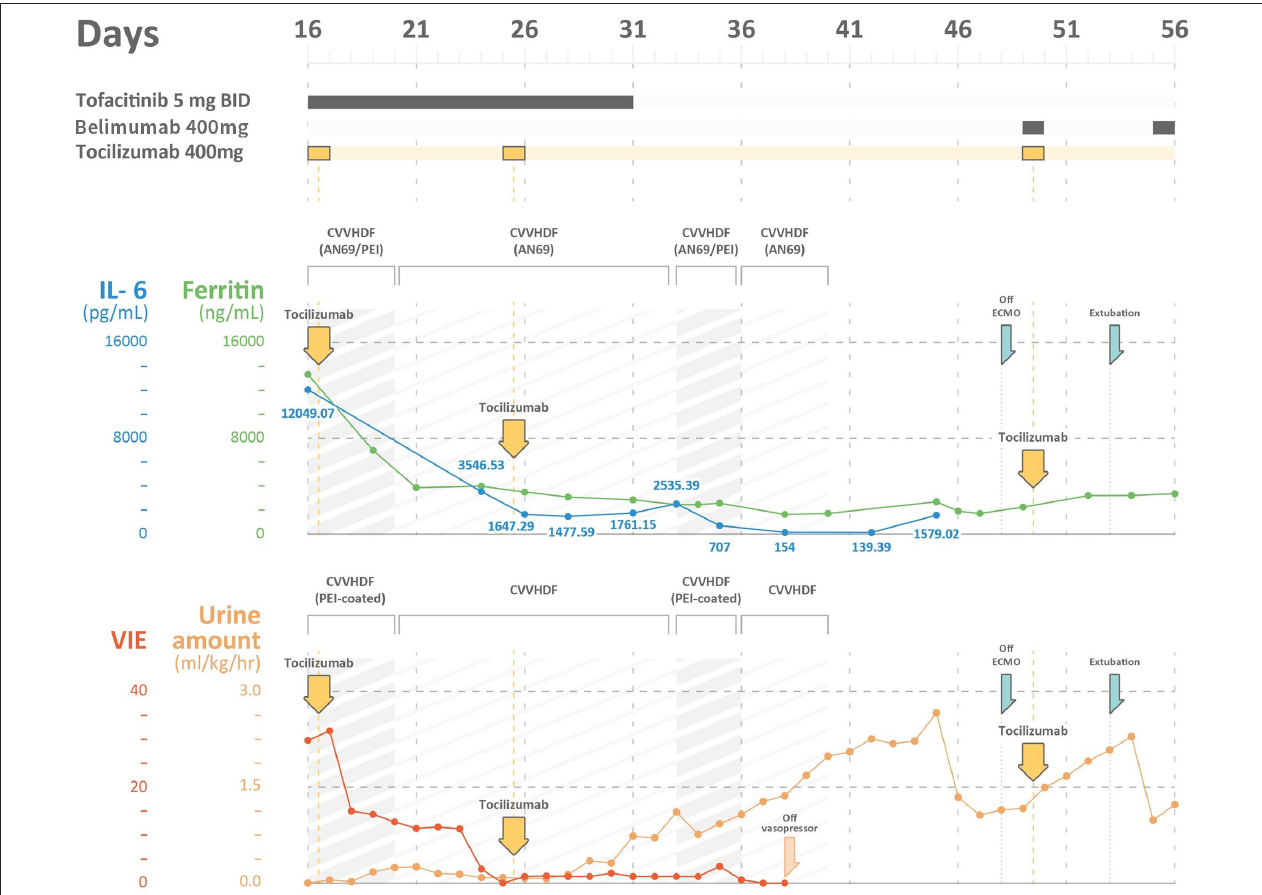
FIGURE 1 | The time course of ferritin levels, IL-6 levels, vasoactive-inotropic equivalent (VIE) scores, and urine amount in a severe COVID-19 patient with multi-organ failures. IL-6, interleukin 6; VIE, vasoactive-inotropic equivalent; CVVHDF, continuous venovenous hemodiafiltration; AN69ST/PEI: hemofilter with AN69 and